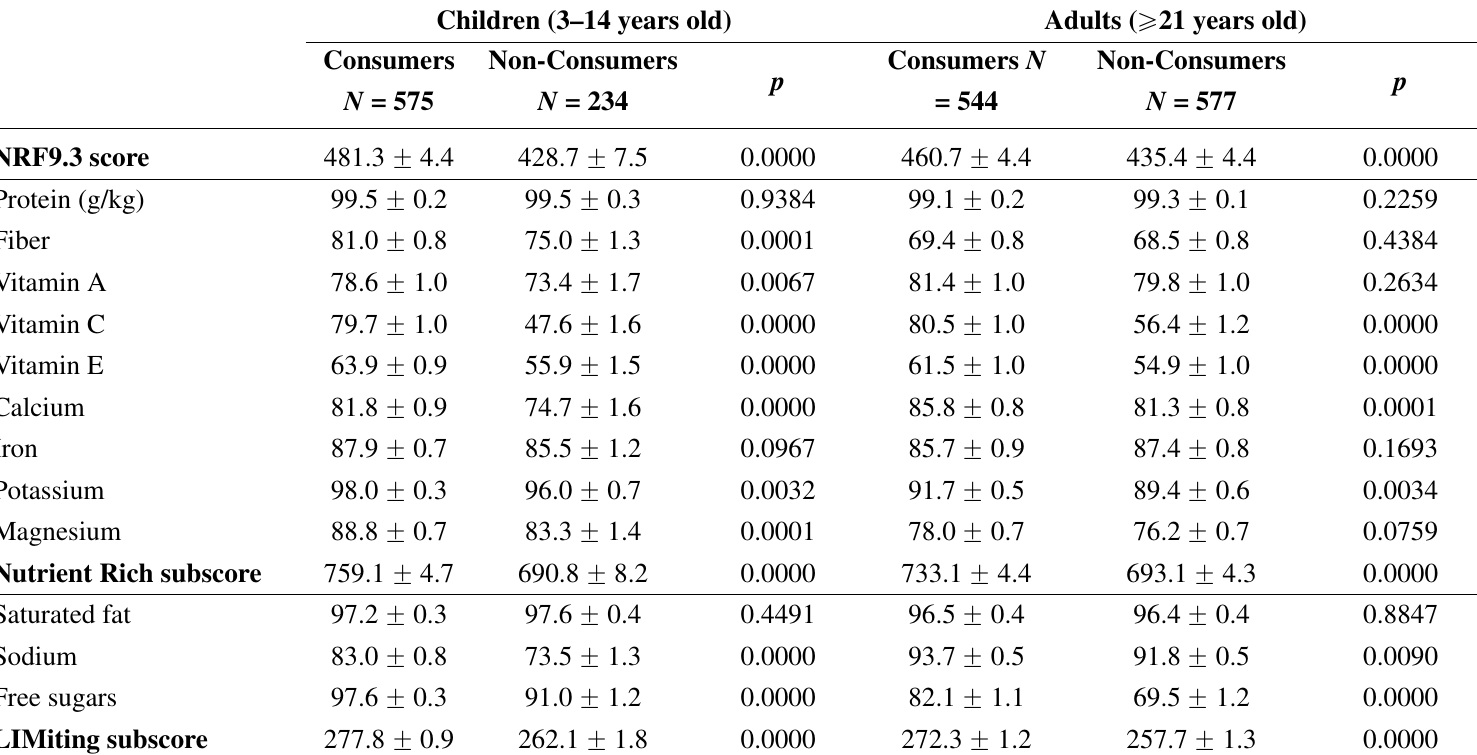
Table 2. NRF9.3 dietary nutrient density scores, subscores and individual components by juice consumers versus non-consumers for each age